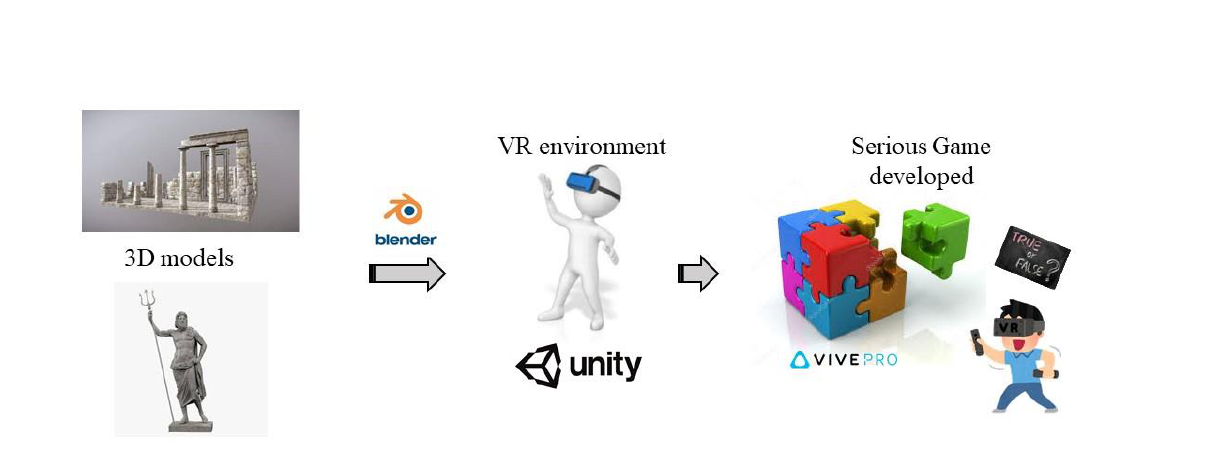
Figure 2: The concept of the application